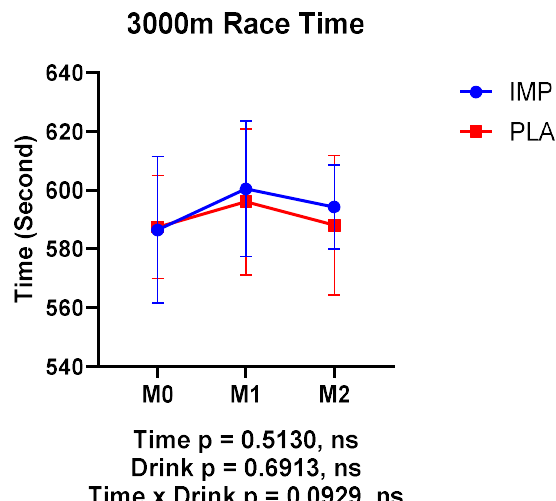
Figure 2. Results of 3000 m time trials. The data are presented as means ± SD.